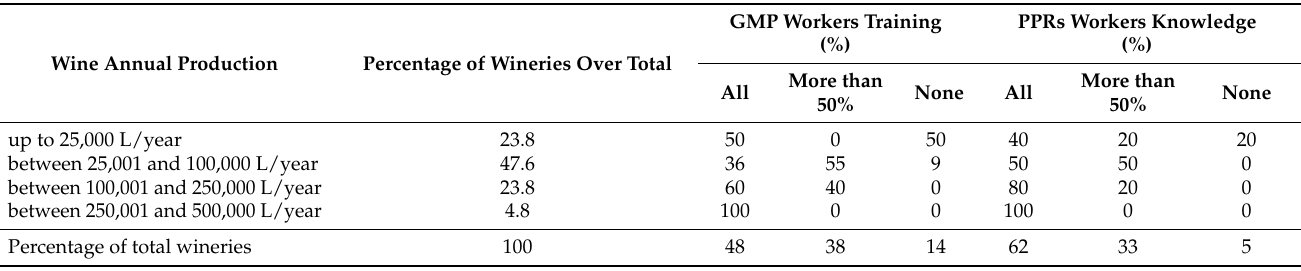
Table 2. GMP workers training and PPRs workers knowledge by type of winery, according to their annual wine production and by the total of the